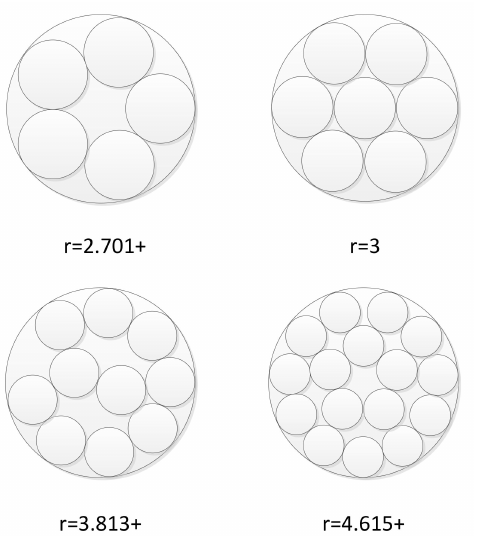
Figure 3. Some of the solutions to the “small circle in a large circle problem”. The term r is the ratio of the diameter of the large circle to that of the small